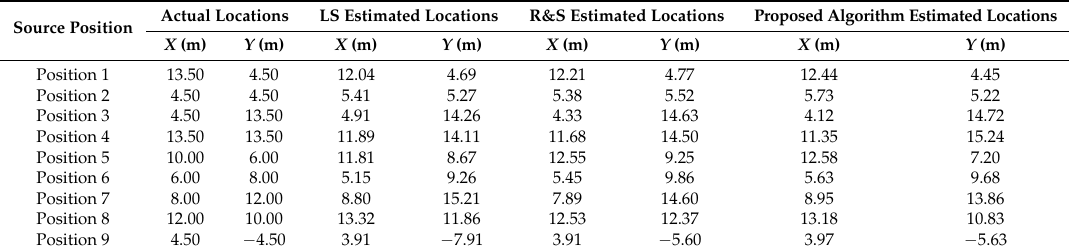
Table 7. Comparison of estimated versus true locations with eight measurement sensors.